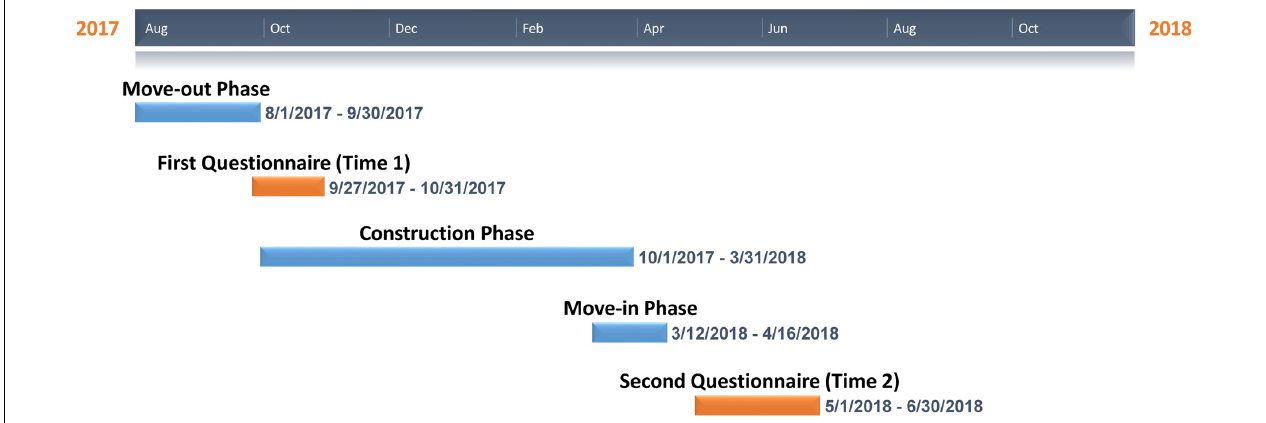
Frontiers in Built Environment |